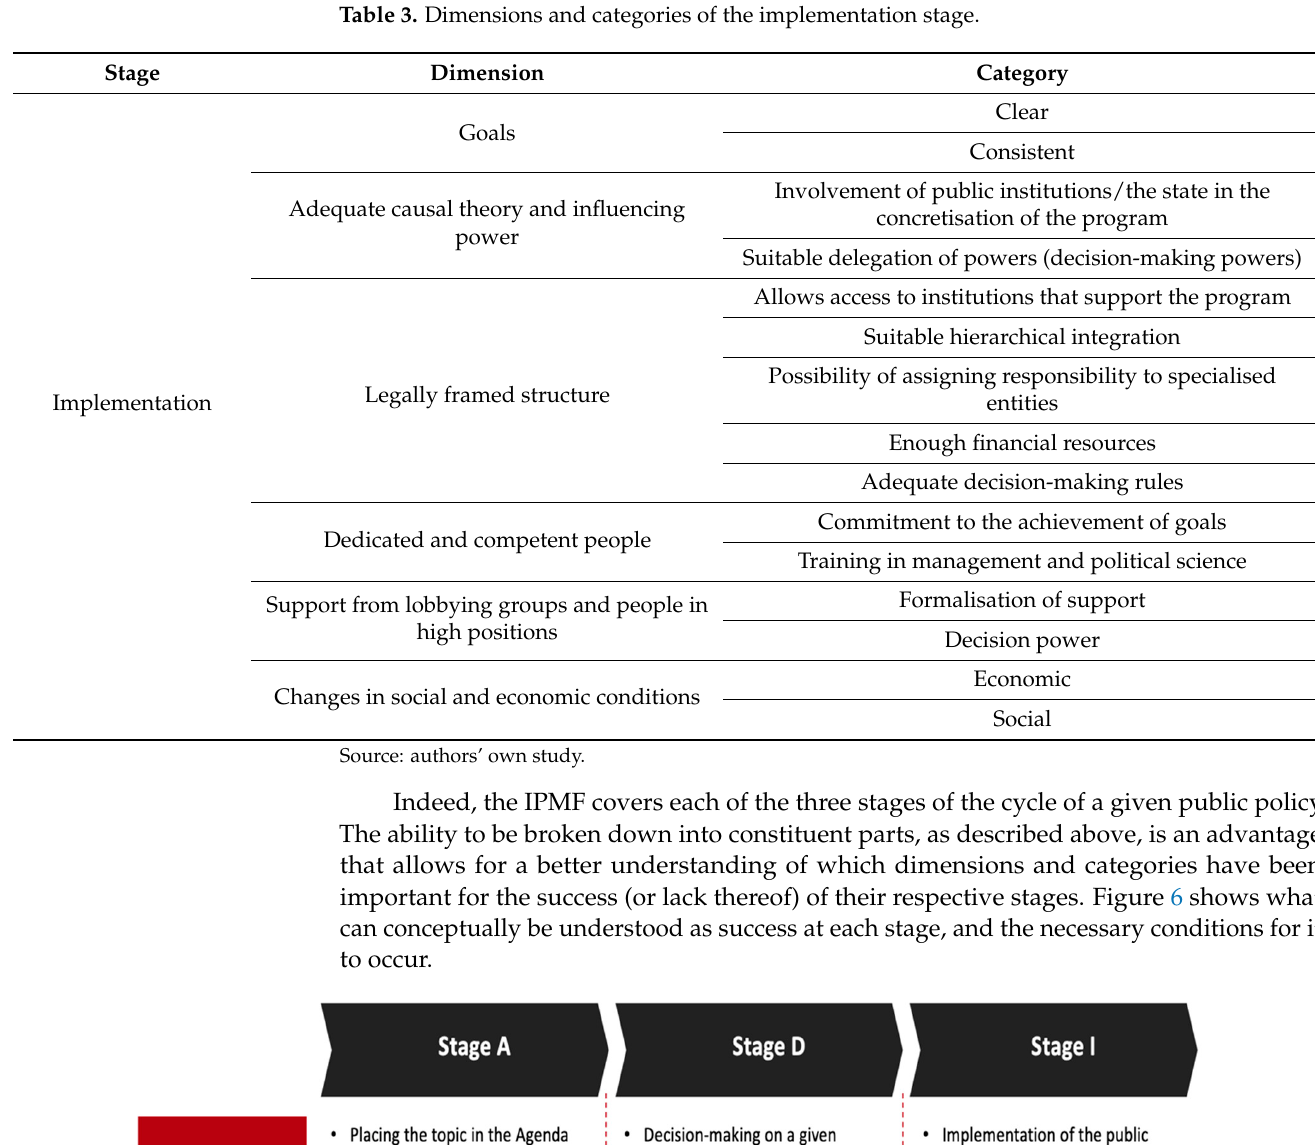
Table 3. Dimensions and categories of the implementation stage.